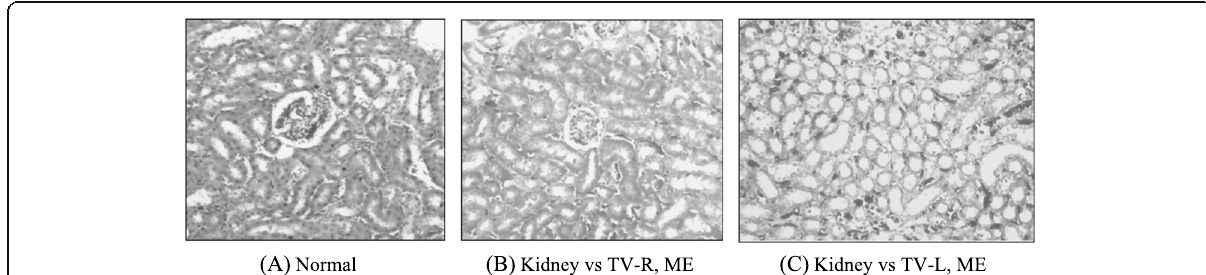
Fig. 1 Histopathological examination of kidney section parts (H & E stained under 10x magnification power) where the slide; ( a ) represent control (normal) ( b ) represent kidney tissues treated with TV-R, ME at doses of 600, 1200 and 2000 mg/kg ( c ) represent kidney tissues treated with TV-L, ME at doses of 600, 1200 and 2000 mg/kg body weight